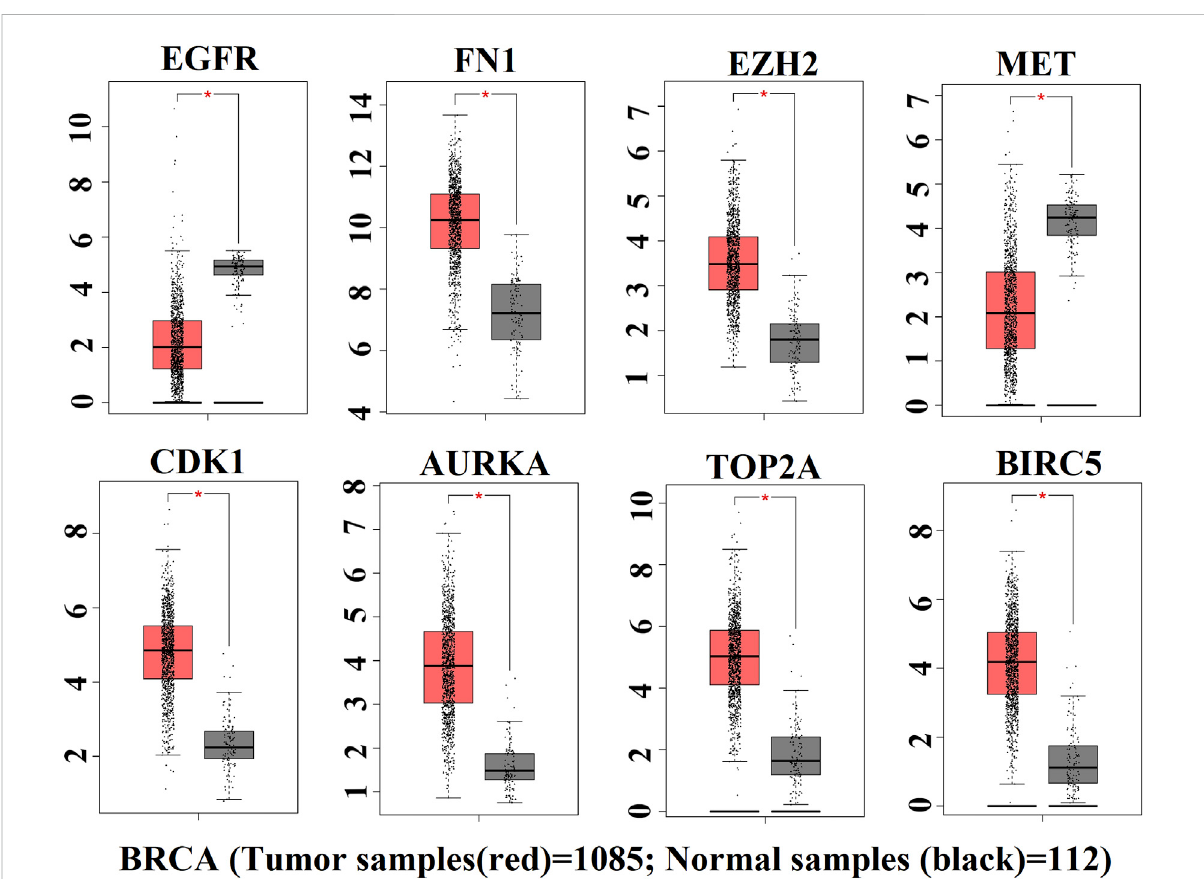
FIGURE 5 Box plot of expression patterns of KGs for RNA-seq data, where red indicates the high-risk group and black indicates the low-risk